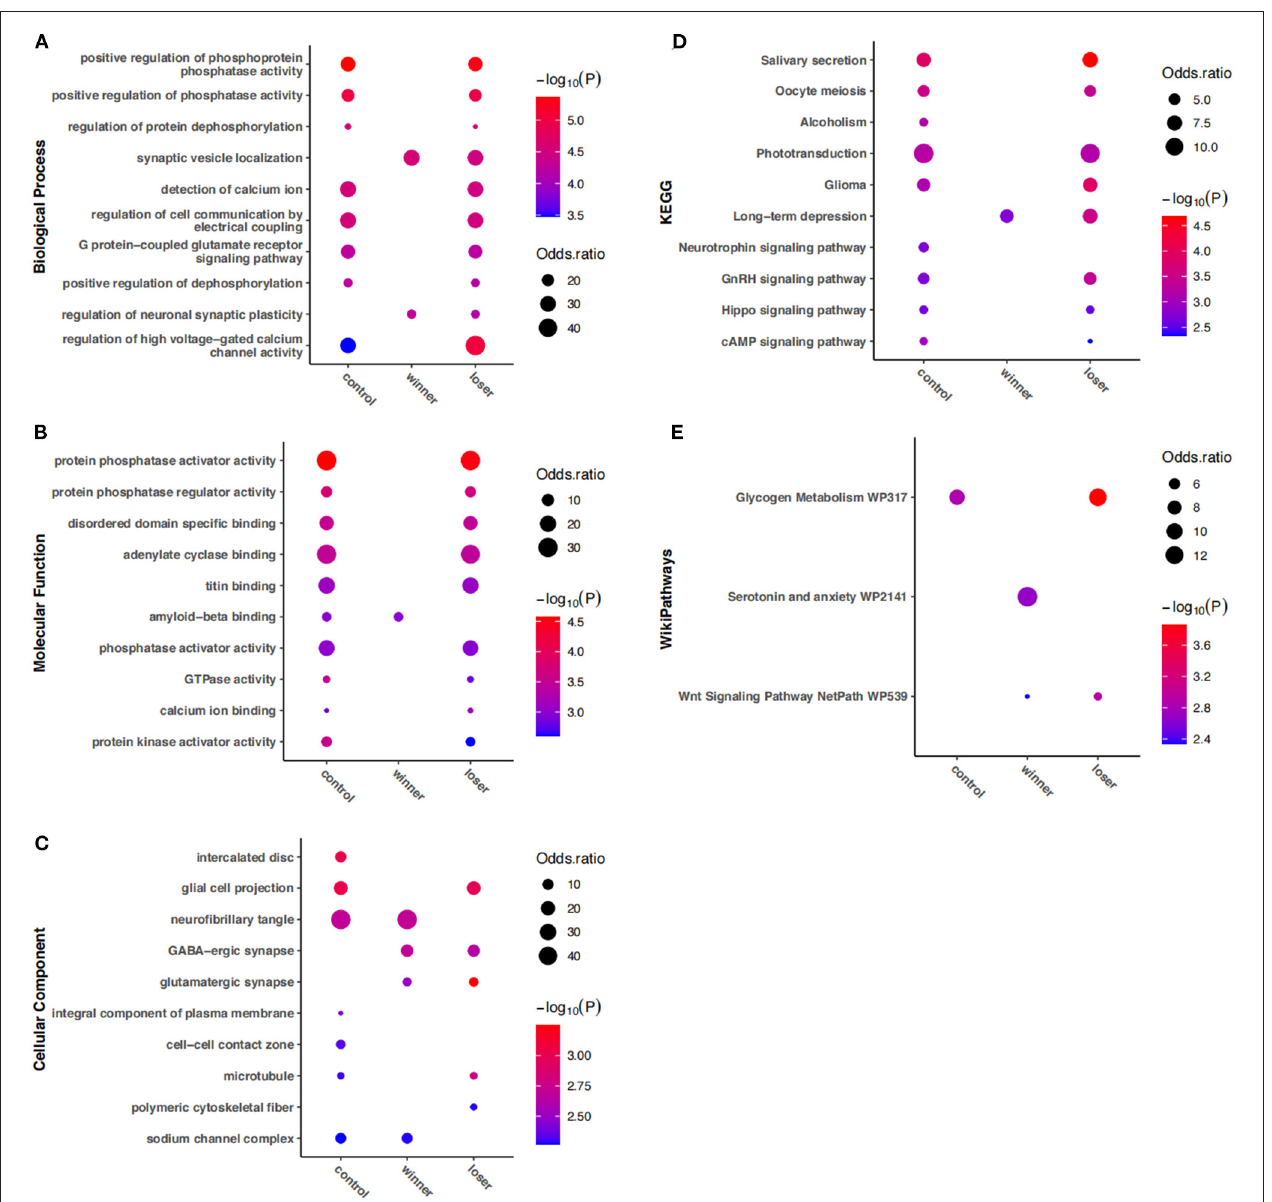
FIGURE 4 | Gene ontology and KEGG pathways enriched by DRE genes among controls, winners, and losers. No more than 10 items with the most significant P -values are shown for (A) biological processes, (B) molecular functions, (C) cellular components, (D) KEGG pathways, and (E) wikipathways, which are insignificant in at least one